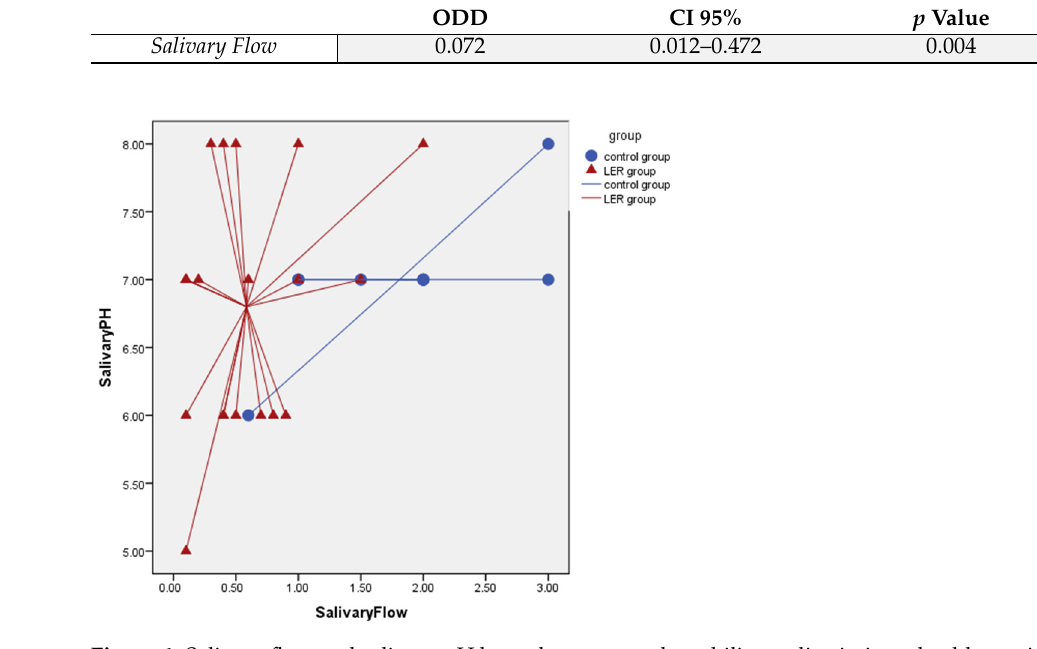
Figure 4. Salivary flow and salivary pH have demonstrated an ability to discriminate healthy patients from those with LPR in 80 of